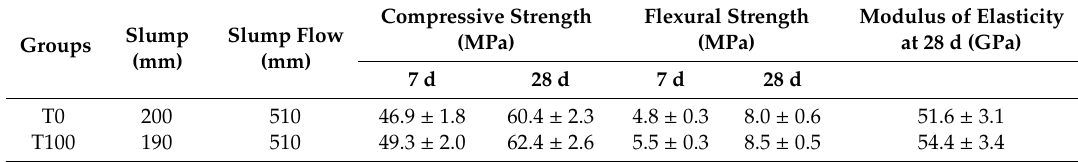
Table 5. Properties of concrete with river sand and iron tailings sand.